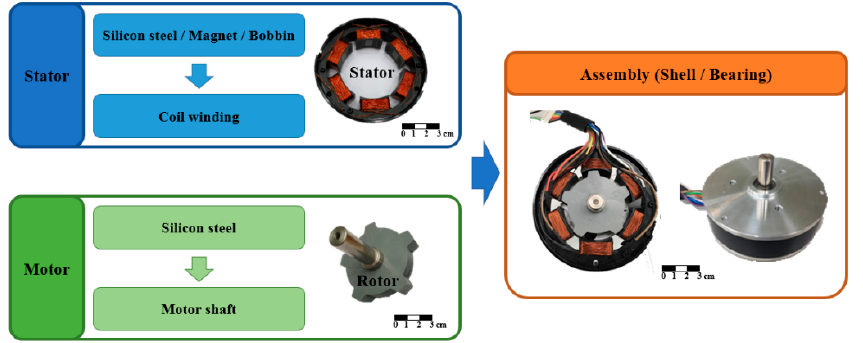
Figure 9. The assembly process of FSPM.